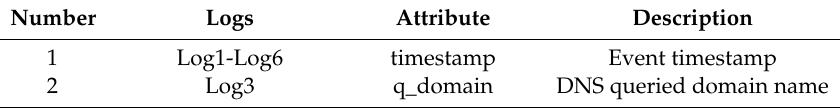
Table 3. The attributes extracted from log